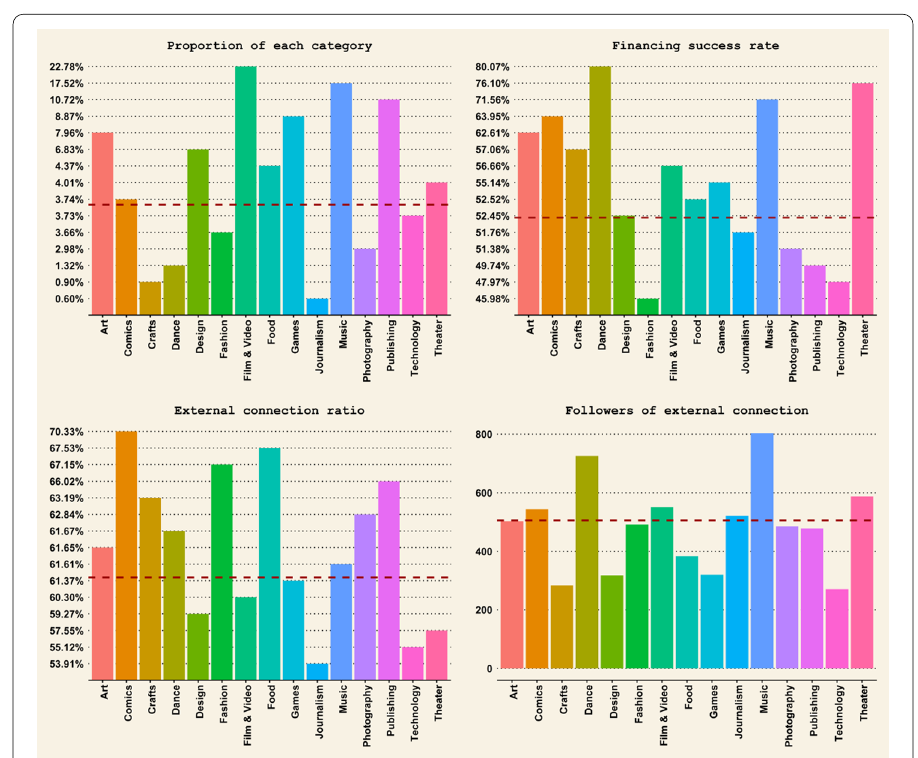
Fig. 1 Comparison by project category (dotted red line denotes mean